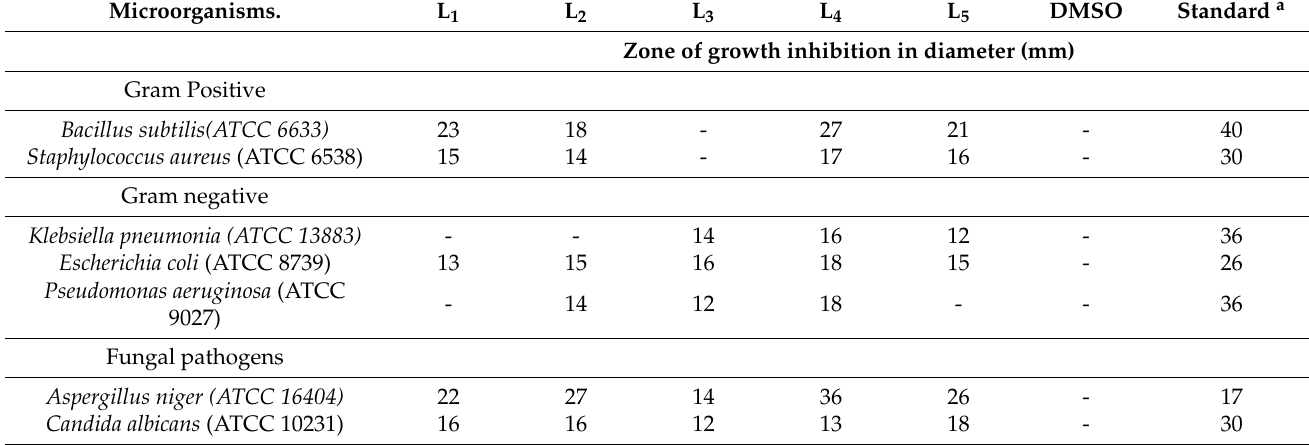
Figure 5. Graphical representation of antibacterial and antifungal activities of Co(II) complexes against bacterial and fungal pathogens. Table 5. Antibacterial and Antifungal activities of Schiff bases ligands.